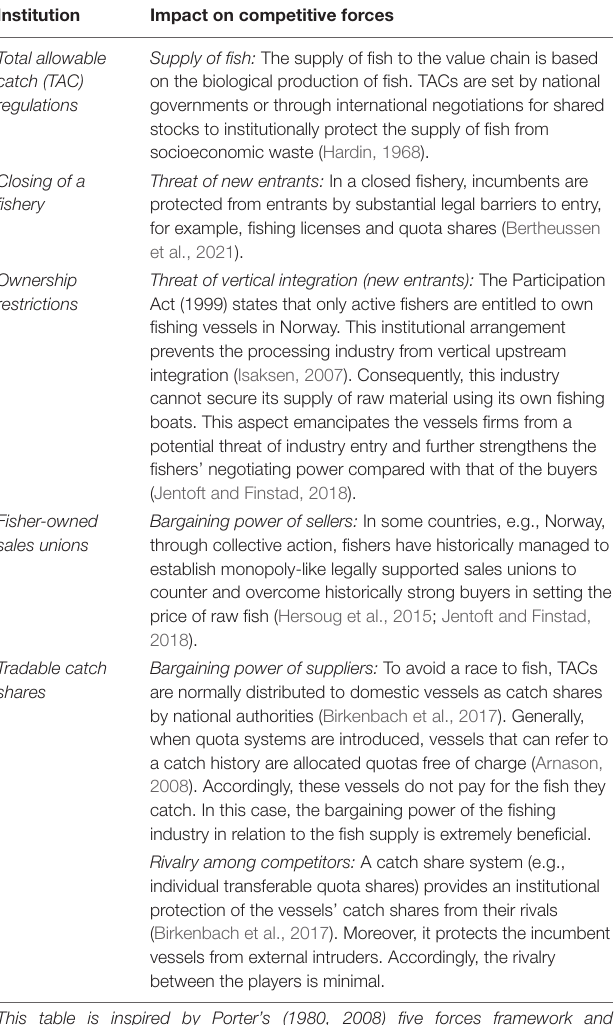
TABLE 1 | Sector-specific institutions of the fish harvesting industry. Institution Impact on competitive